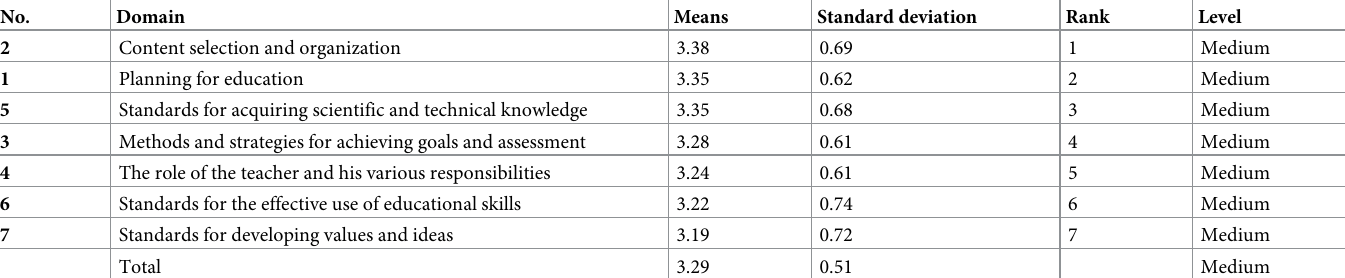
Table 4. The means and standard deviations of the participants’ responses on the assessment level of the quality of training programs for students with disabilities in light of modern trends. No.